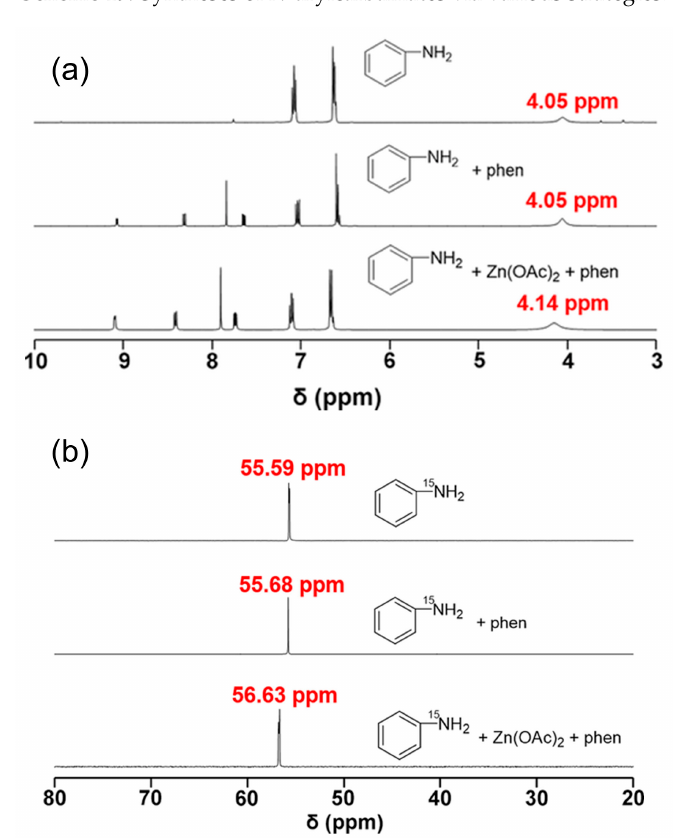
Figure 7. (a) 1 H- and (b) 15 N-NMR spectra of aniline with and without Zn(OAc) 2 /phen in CD 3 CN at room temperature. The chemical shifts in both 1 H and 15 N-NMR spectra illustrated the interaction between aniline and acetate, and the formation of hydrogen bonds. Reprinted with permission from ref. [107] (Copyright 2017 John Wiley and Sons).